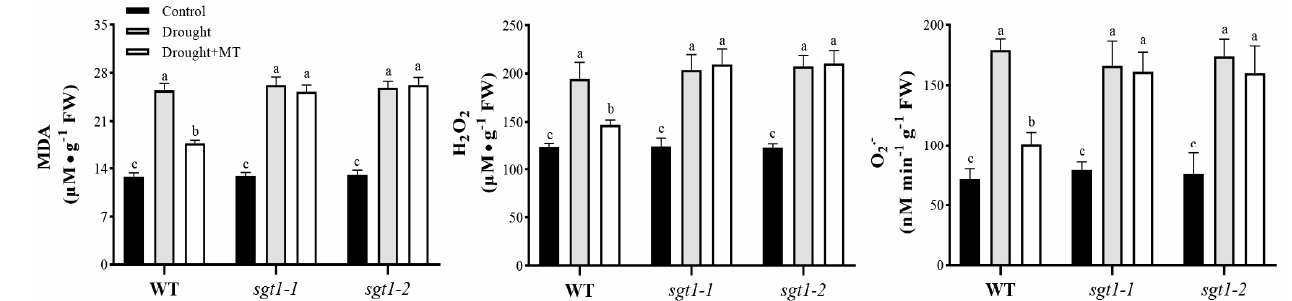
Figure 2. Effects of melatonin treatments on oxidative damages under drought stress. Contents of hydrogen peroxide (H 2 O 2 ) and malondialdehyde (MDA), and superoxide (O 2 − ) production rates, were examined in the leaves of wild-type (WT) and sgt1 mutant seedlings treated with melatonin (MT; 100 µ M) under drought stress. Difference in letters indicates significant differences according to Tukey’s Multiple Comparison Test ( p < 0.05).